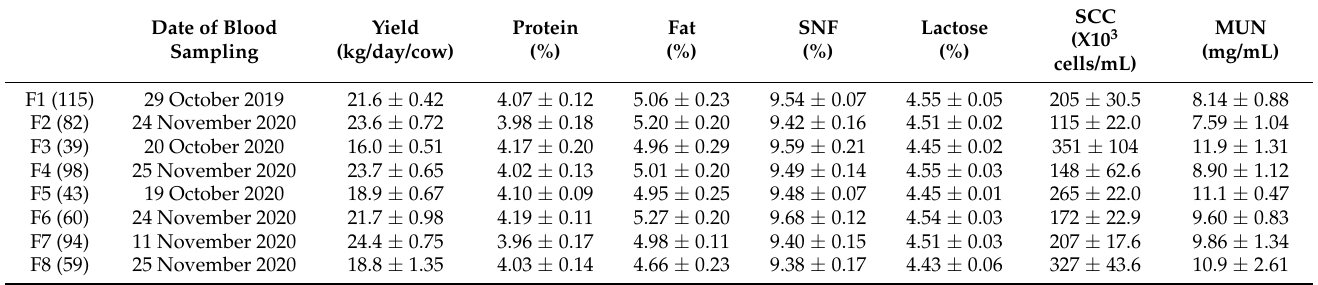
Table 2. Milk yield and composition of Jersey herds from eight farms examined in this